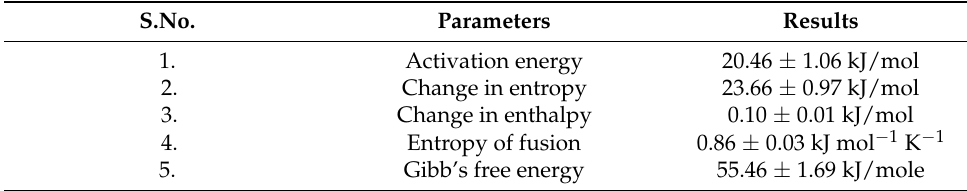
Table 1. Evaluated parameters of